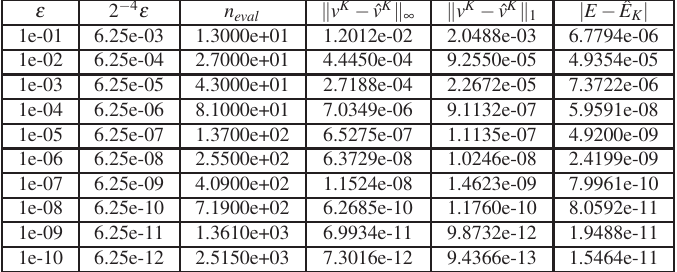
Table 9 Parameters as specified in Table 1 for f 1 , K = 15 and the cubic rule. ε k = ε varies between 10 − 1 and 10 − 10 .